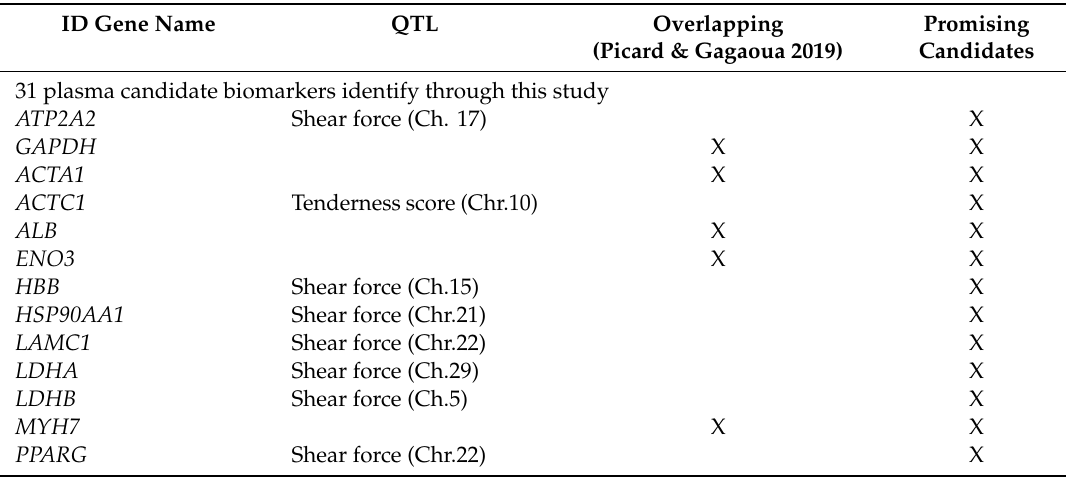
Table 6. List of the 33 promising plasma biomarkers associated with beef tenderness identified in this